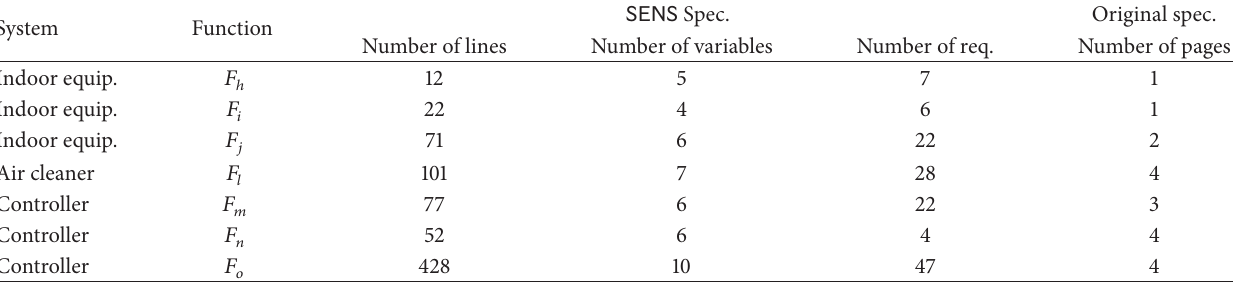
Table 2: Scales of example SENS specifications.